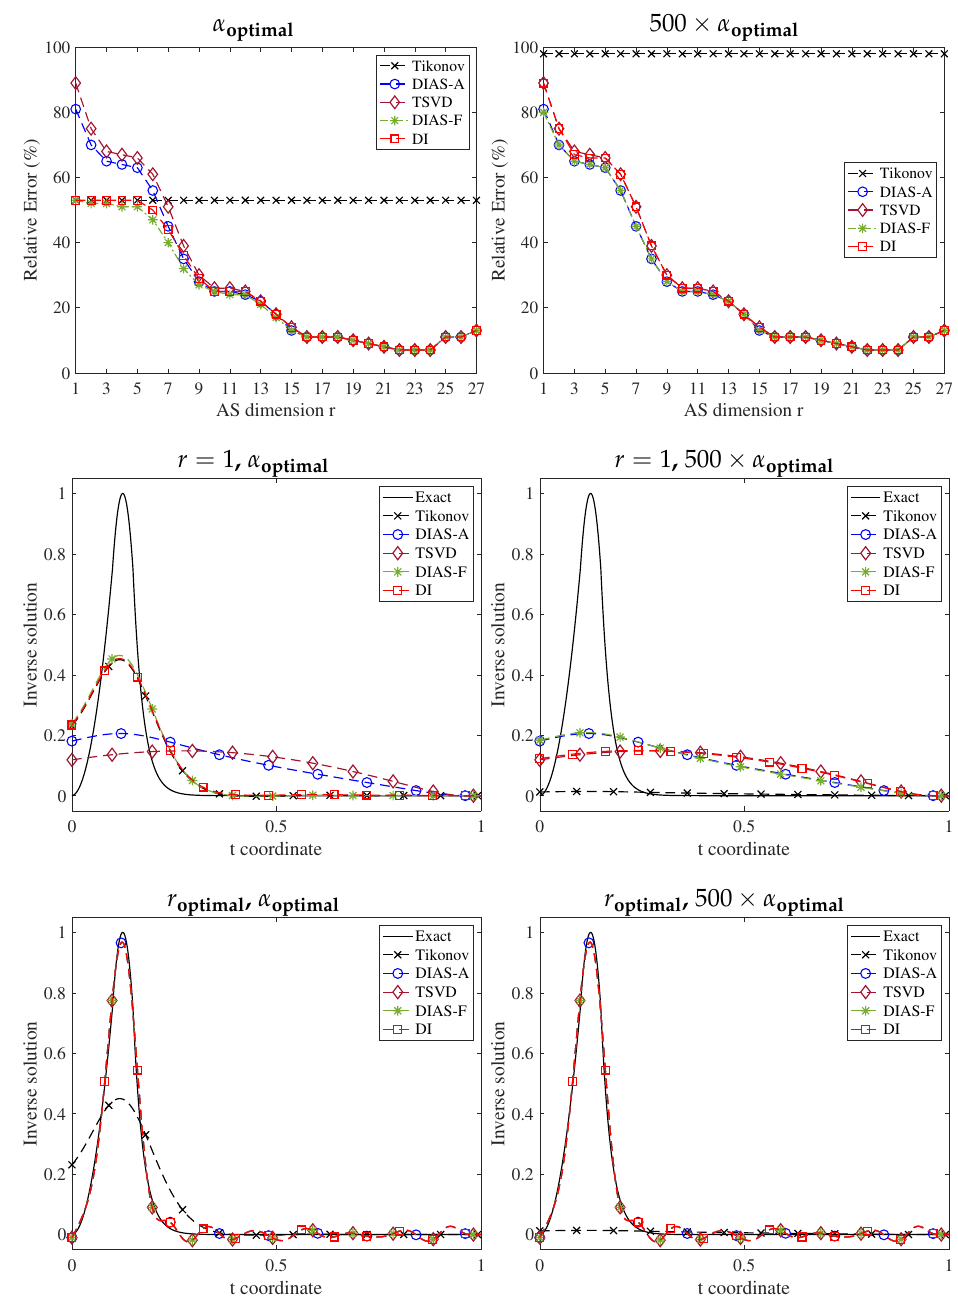
Figure 7. Heat, α optimal = 3.35 × 10 − 3 . Comparison of different DIAS regularizations and Tikhonov regularization. Top row: relative errors in the inverse solutions for different regularization methods for two values of regularization parameter. Middle row: inverse solutions with DIAS regularizations with one-dimensional active subspace and Tikhonov regularization for two values of regularization parameter. Bottom row: inverse solutions with DIAS regularizations with the optimal dimension ac- tive subspace ( r optimal = 22) and Tikhonov regularization for two values of regularization